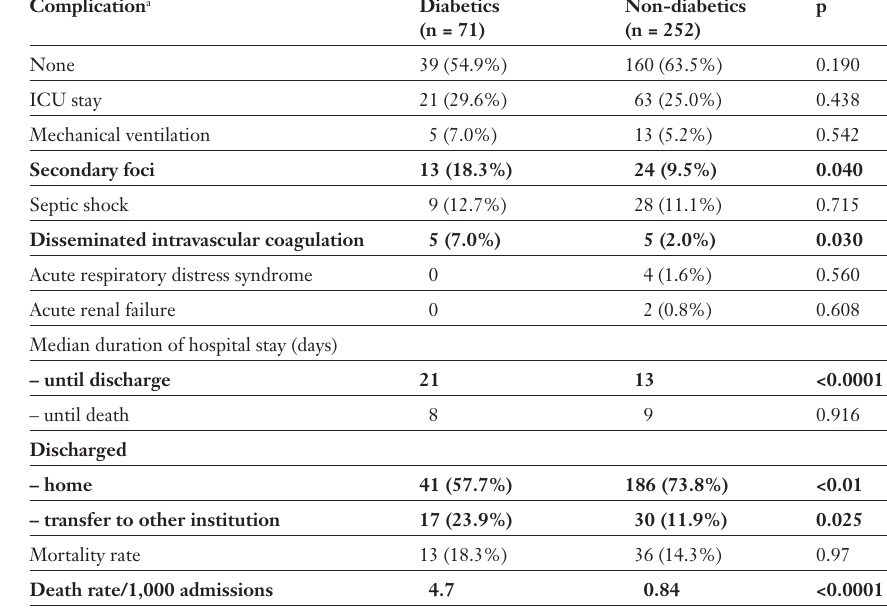
Complications and outcome.